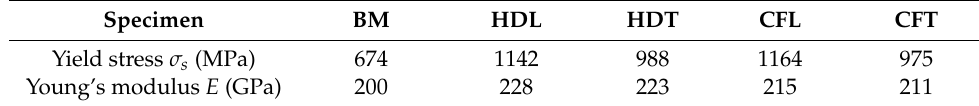
Table 4. The tensile properties of five specimens.